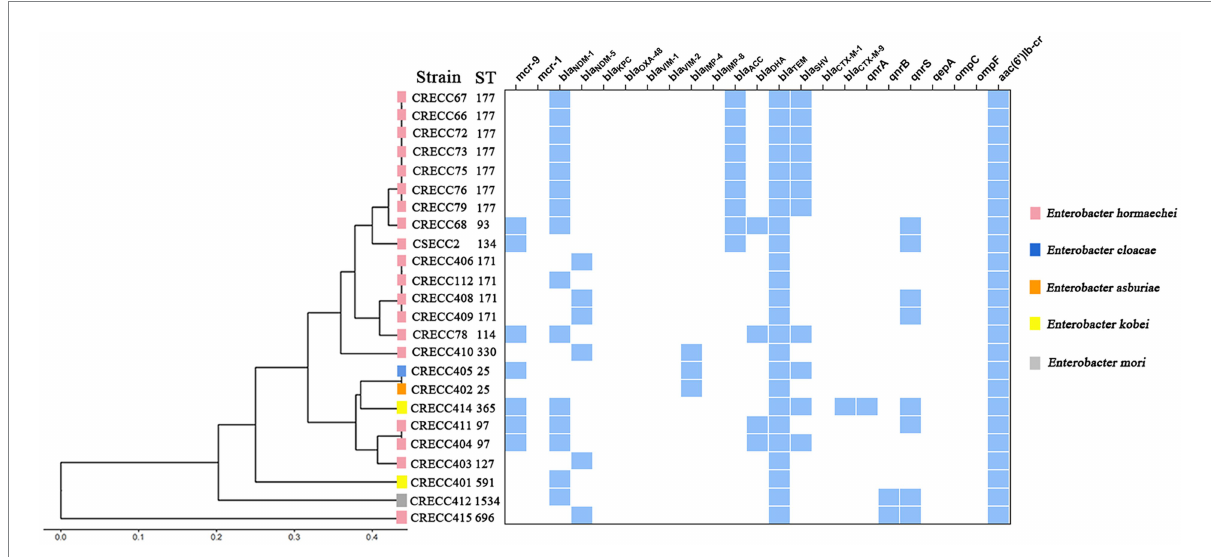
FIGURE 1 Clustering analysis and resistance determinants of 24 ECC strains from our institution. The resulting structure reflected the similarity between the sequences, and resistance determinants present (in blue) in each strain are shown on the